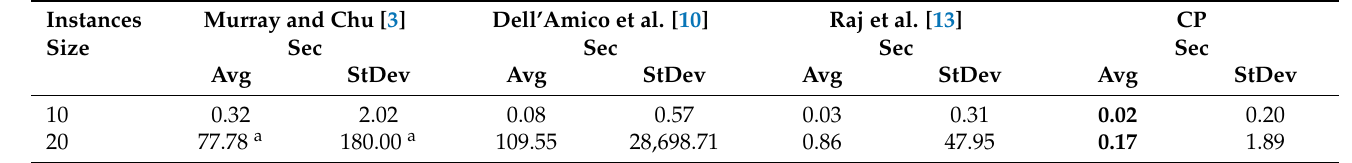
Table 1. Instances from [3]. Comparison of exact